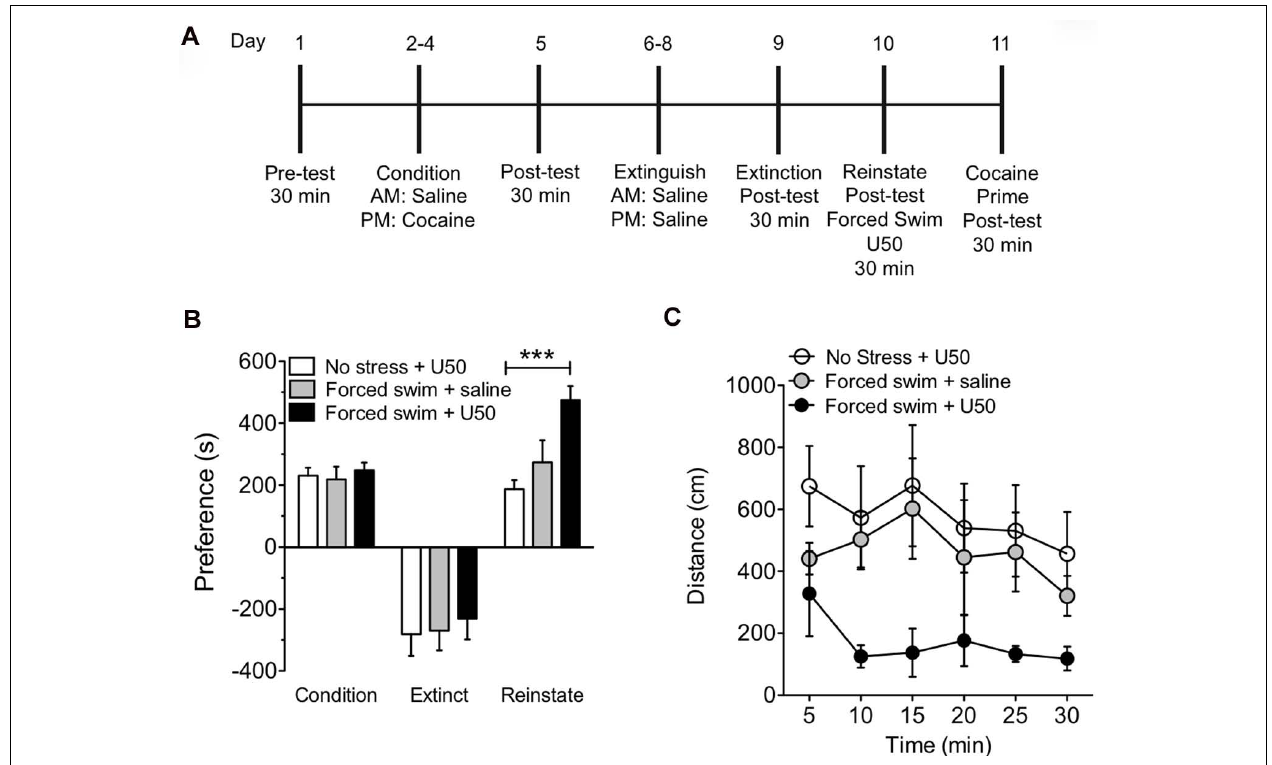
FIGURE 1 |Acute forced swim stress potentiates U50,488-induced reinstatement of cocaine place preference. (A) Timeline of cocaine place preference-reinstatement experimental paradigm. (B) Cocaine preference scores (day 5), calculated as post-test minus pre-test on the cocaine-paired side (condition) and U50,488-induced (5 mg/kg, i.p.) reinstatement scores (day 10) of extinguished place preference (reinstate). Data show a significant potentiation in KOR-reinstatement following forced swim stress and U50,488.